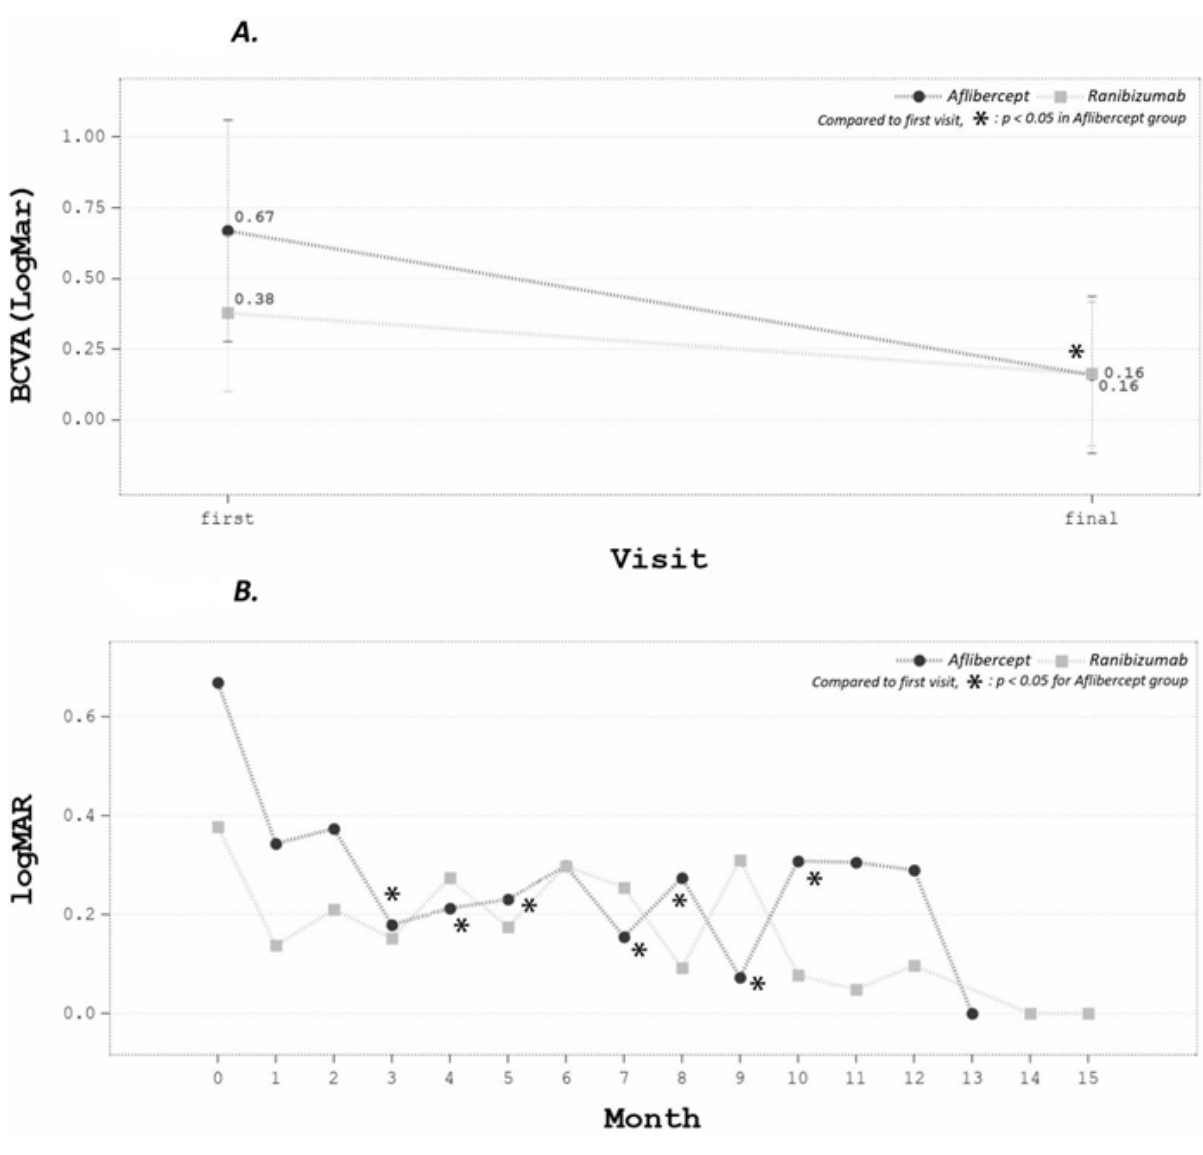
Figure 2. ( A ) The BCVA improvement was more prominent in the aflibercept group. ( B ) From